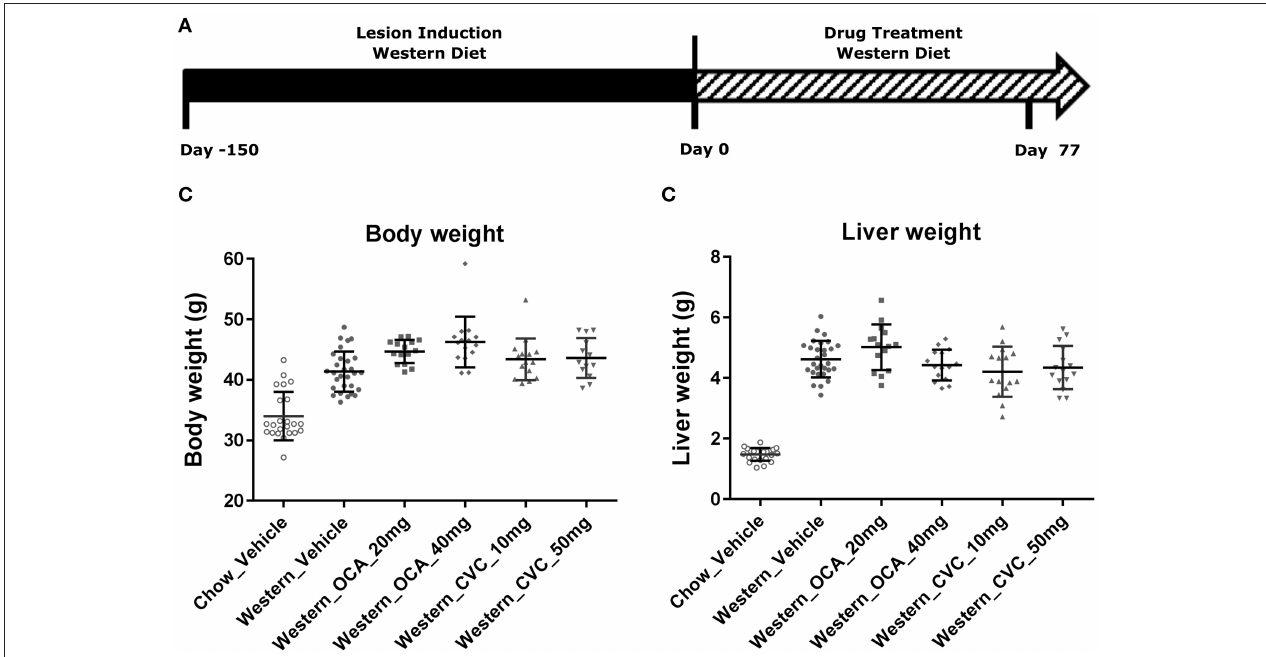
FIGURE 7 | Pharmacological studies of Ocaliva (OCA) and Cenicriviroc (CVC) in the NASH Mice induced by Western diet. NASH mice fed Western diet for 150 days were treated with vehicle, OCA or CVC as described in (A) . Their body weight (B) recorded before euthanasia, and liver weight (C) were measured immediately after euthanasia. The statistical analysis (One way ANOVA) was performed and no statistical significance was found.